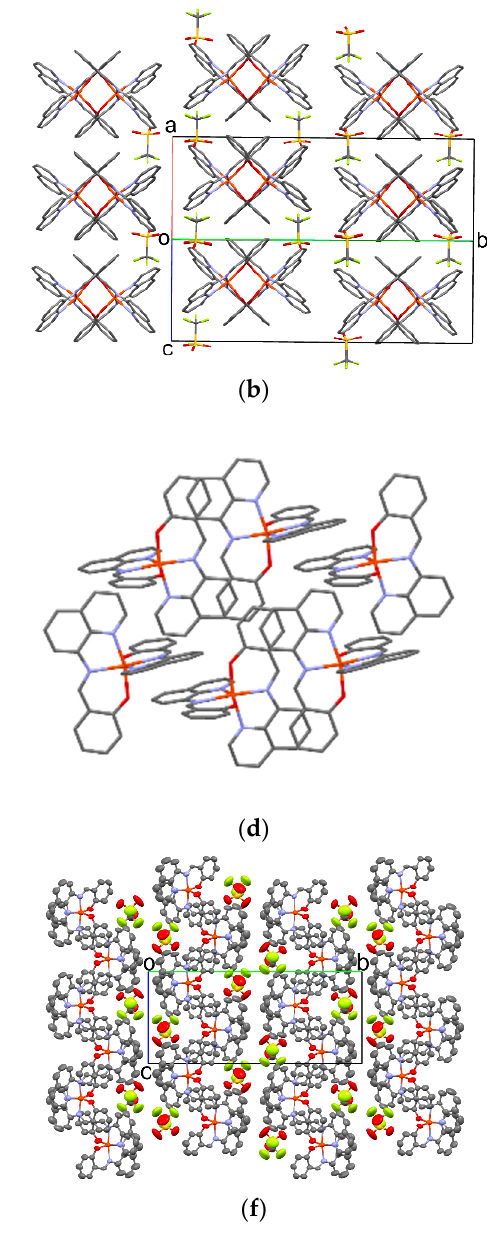
Figure 8. Crystal structure viewed along the a + c direction of 2 at 293 K ( a ) and 400 K ( b ). Hydrogen atoms are omitted for clarity; π -stacking structures of the [Fe(qsal) 2 ] cations along the ac plane at 293 K ( c ) and 400 K ( d ); ORTEP drawings of 2 with 50% probability at 293 K ( e ) and 400 K ( f ).